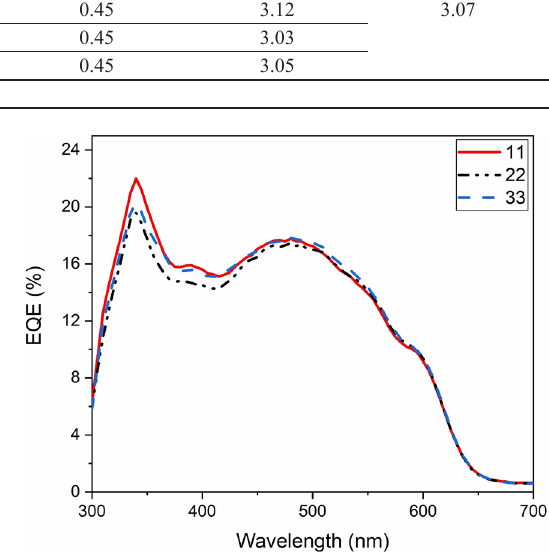
Figure 9. J-V curves of the device fabricated in the Experiment C with the configuration of FTO/TiO